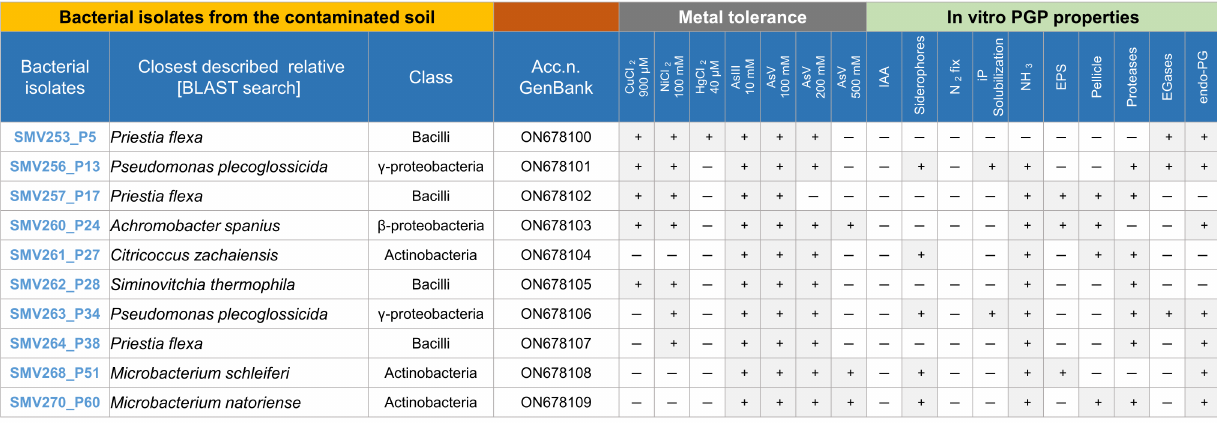
Figure 1. List of arsenic-tolerant bacteria isolated from the As-contaminated soil and results of the tests performed on them. GenBank Accession number, metal tolerance, and in vitro PGP properties are